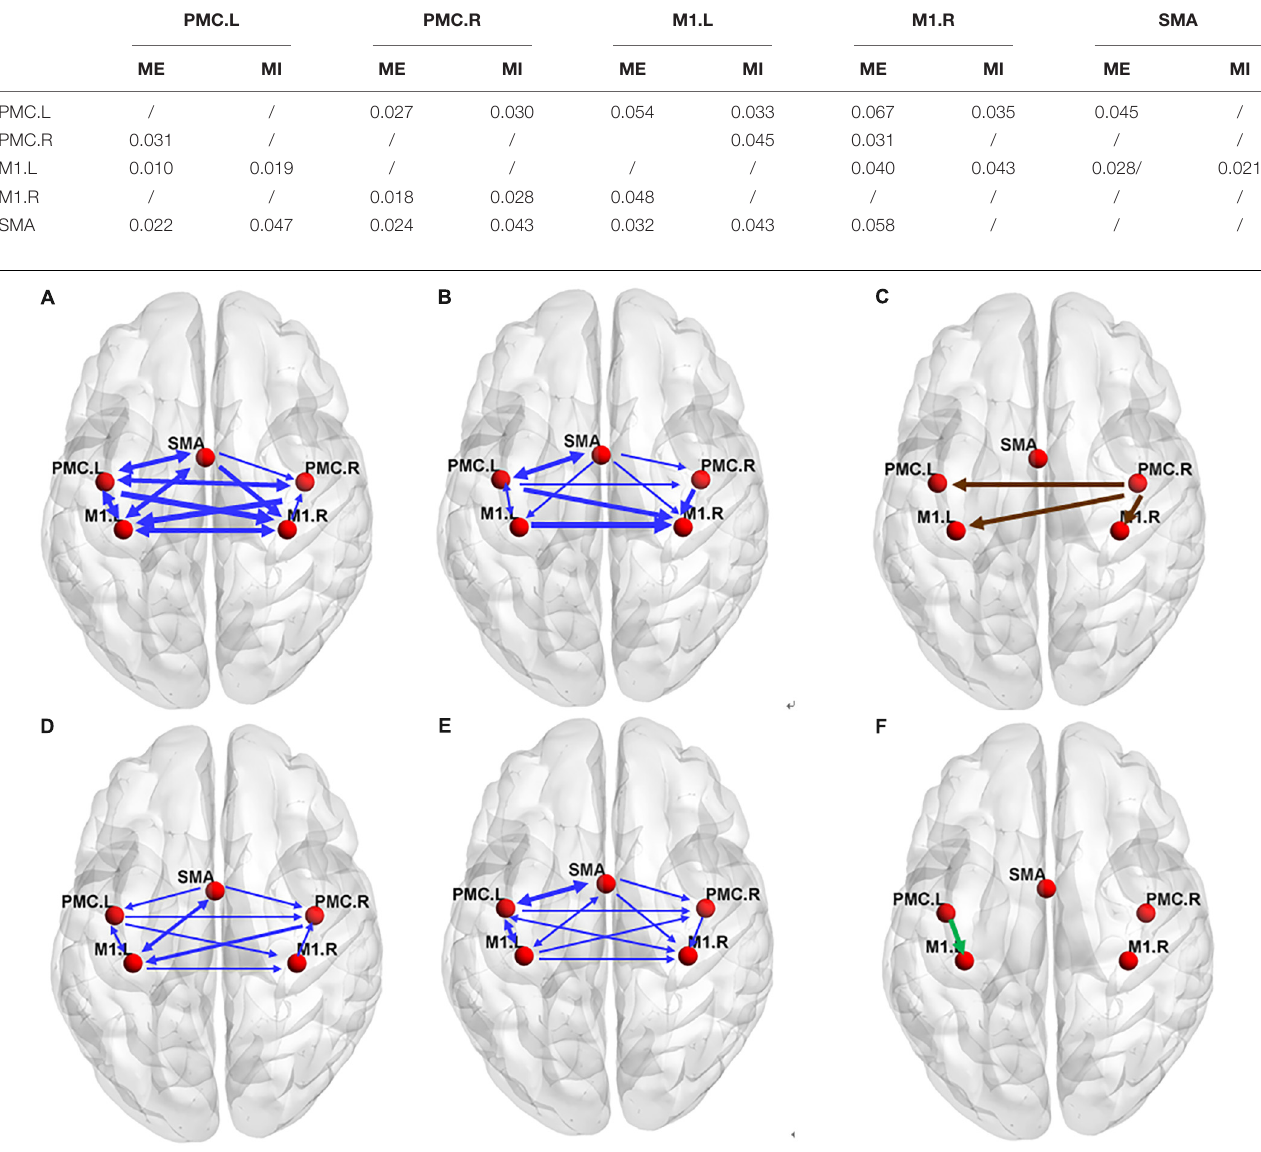
TABLE 2 | The value of conditional Granger causality in the older group during ME and MI. PMC.L PMC.R M1.L M1.R SMA